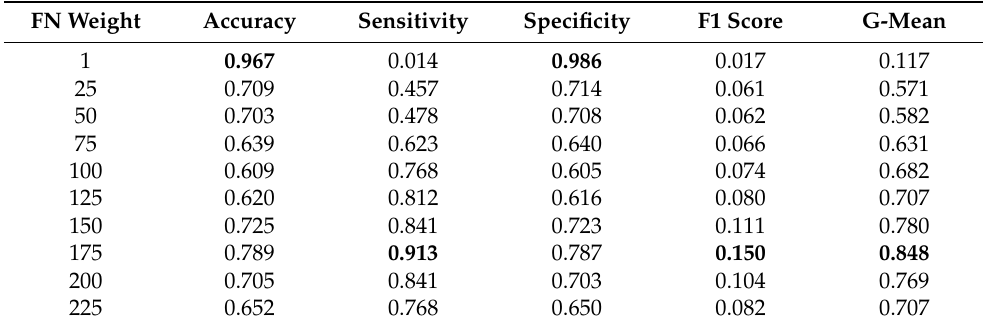
Table 7. The effects of the weight of false negative predictions on all metrics using the CSO (for the dataset of Polish companies). The best result for each metric is marked in